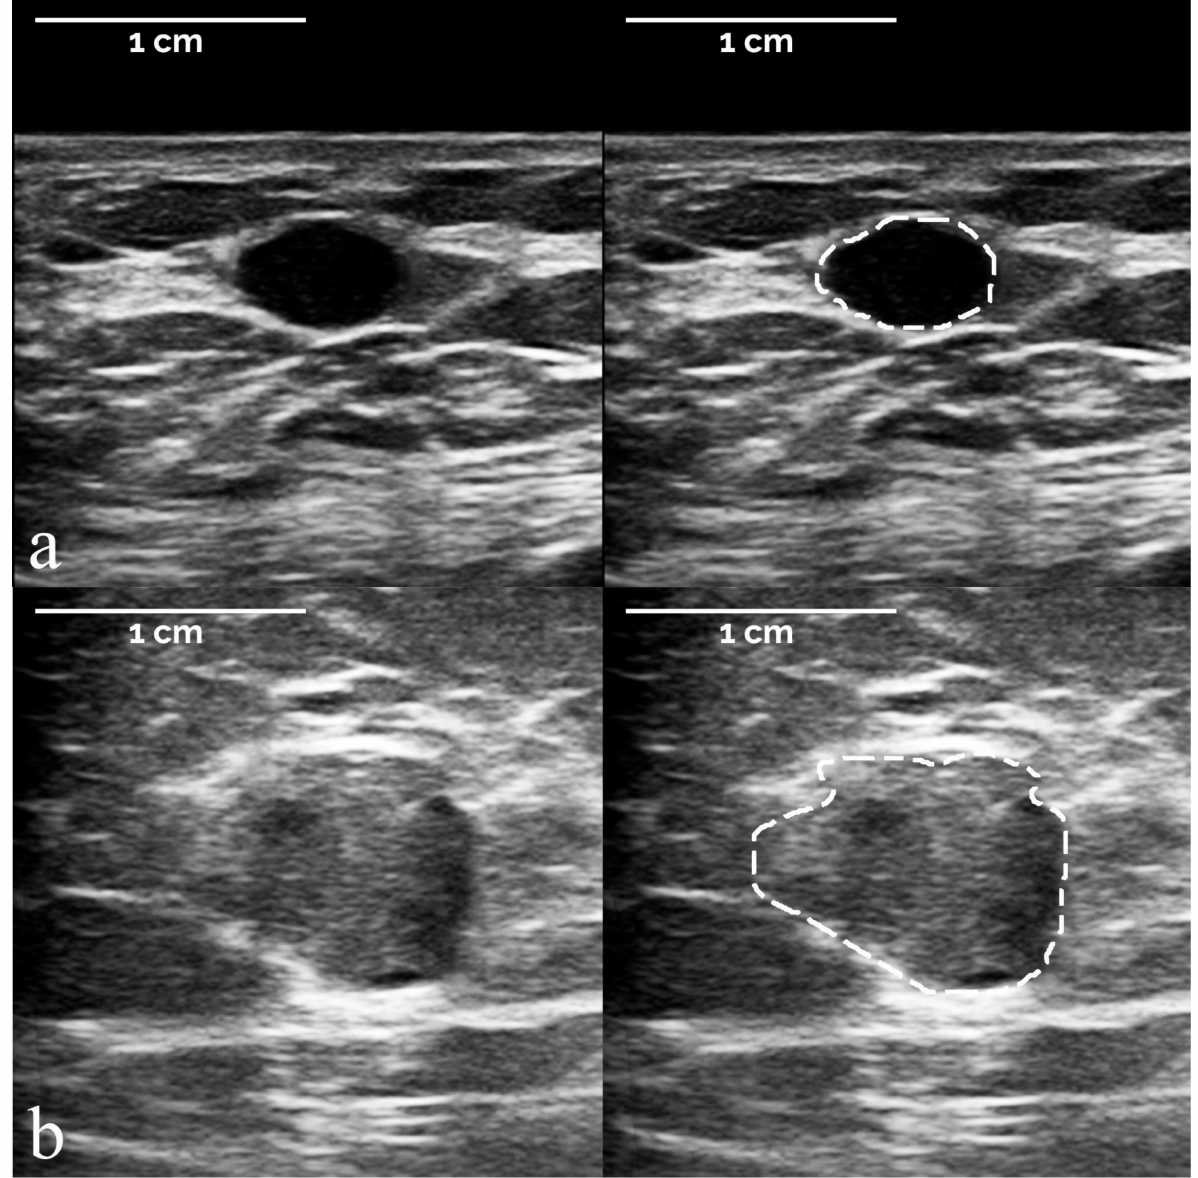
Figure 3. Representative examples of two benign lesions according to histological diagnosis, as classified by the developed radiomic machine learning system. First row ( a ): true negative (benign lesion correctly classified as < 2% likelihood of cancer); second row ( b ): false positive (benign lesion incorrectly classified as > 2% likelihood of cancer). ROIs were manually defined by the expert breast radiologist to segment the suspicious breast lesion. Radiomic features: ( a ) compactness 0.807; acircularity 0.113; center of mass shift 3.495; zone size non-uniformity 743.6; ( b ) compactness 0.718; acircularity 0.181; center of mass shift 4.458; zone size non-uniformity 2255.5. Histopathology: ( a ) cyst; ( b ) fibroepithelial